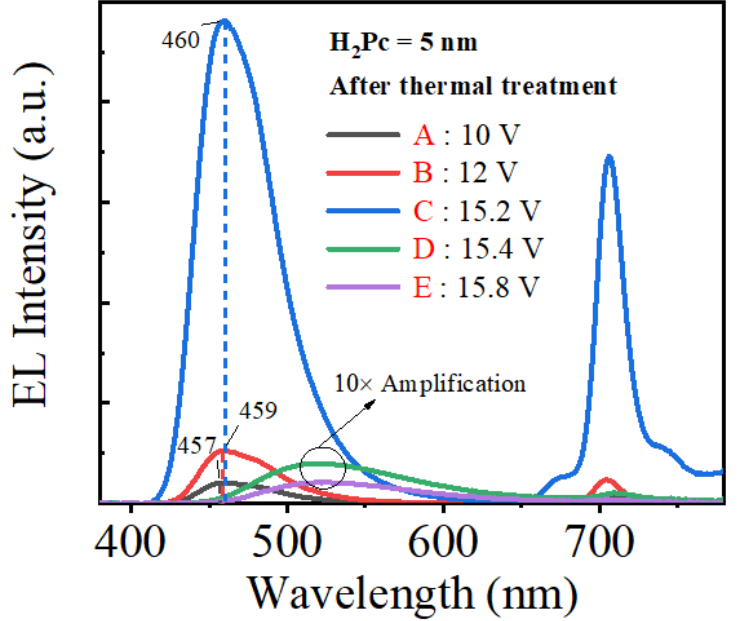
Figure 7. EL spectra of the CTOLED after thermal treatment at applied voltages of A, B, and C, D, and E shown in Figure 6a. At the applied voltages of D and E, ELs are shown to be amplified 10 times.